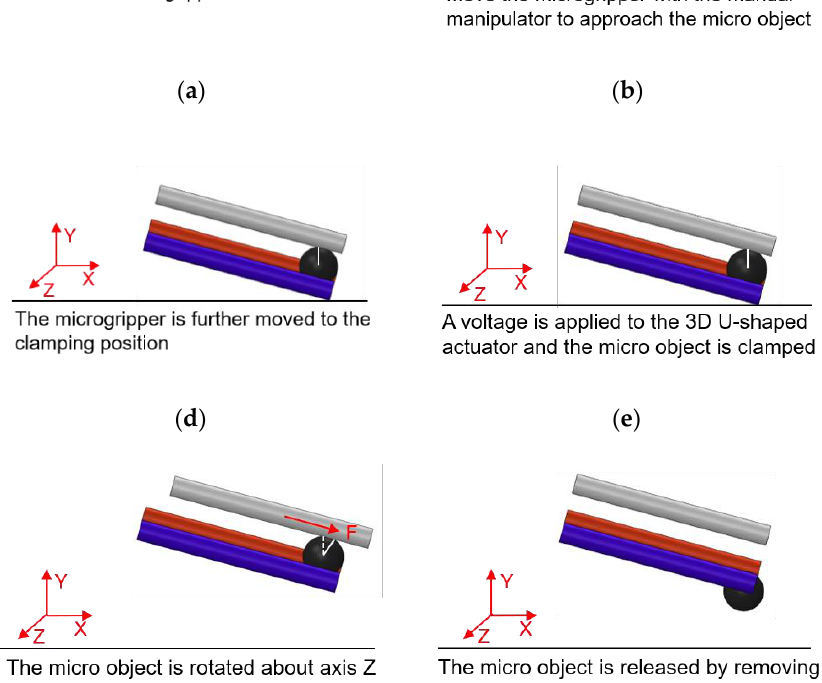
Figure 12. The schematic diagram of micro-objects manipulations.